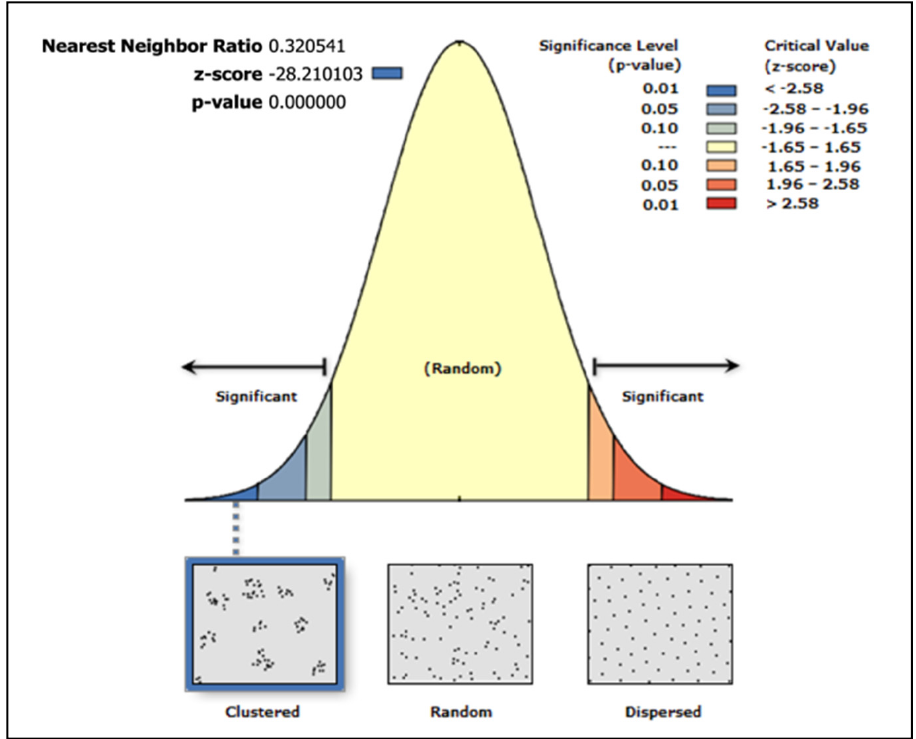
Figure 2. ANN analysis of Buddhist temple distribution recorded in the Xianchun Lin’an zhi 咸淳臨安志 ( Records about Lin’an from the Xianchun Reign ).